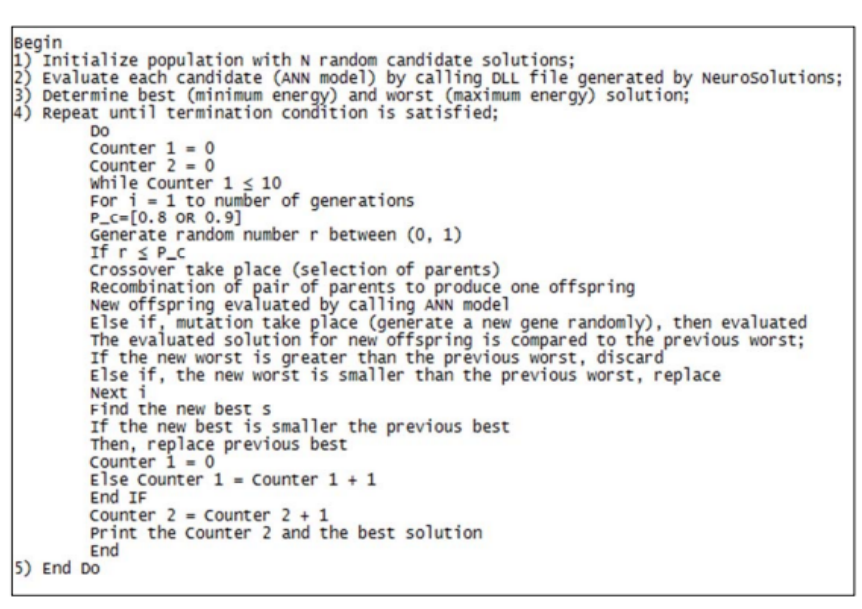
Figure 4. Genetic algorithm pseudo code.